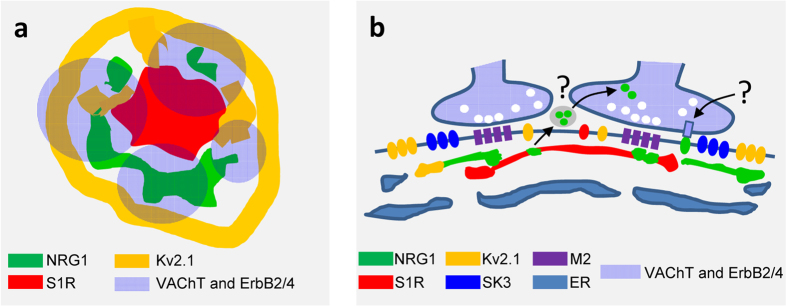
Model showing the possible distribution of some proteins specifically concentrated at C-type synapses.The synapse is displayed in orthogonal (a) and lateral (b) views. The different sub-compartments in which proteins accumulate are depicted according to the indicated colour code. Since the mechanism by which postsynaptic NRG1 and presynaptic ErbBs interact is unknown, two possible routes are indicated with question marks: one mediated by exosomes, and the other involving a juxtacrine interaction.